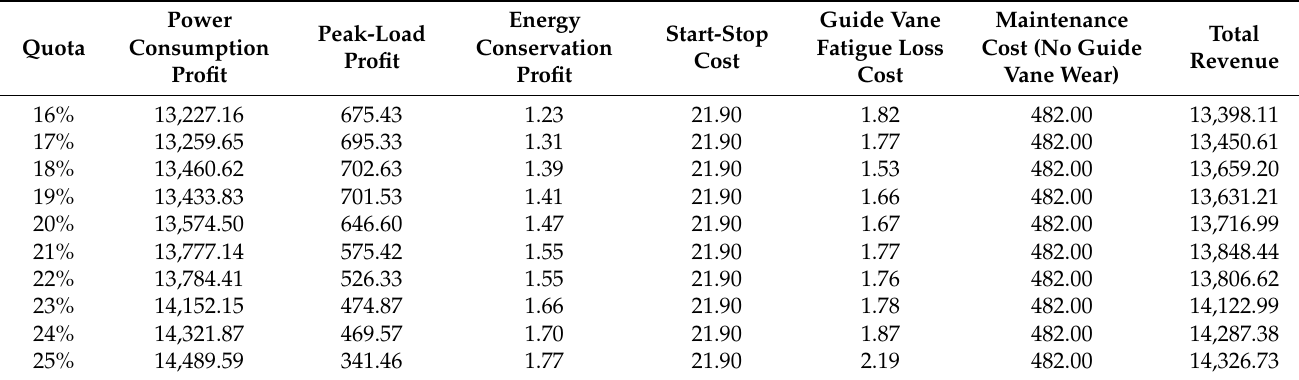
Table 2. The quantified comprehensive regulation benefits of the coal-fired/wind/hydropower hybrid power system.